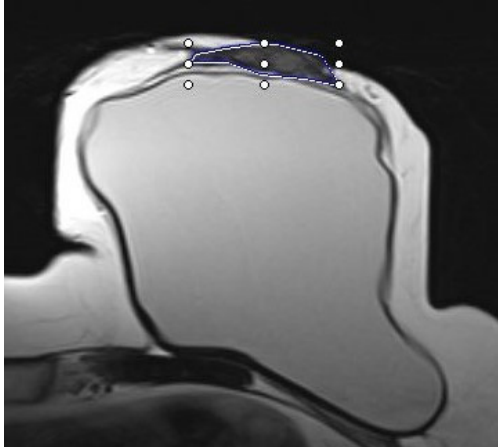
Figure 5. Volumetry of residual glandular tissue after risk-reducing mastectomy with implant T2- weighted image. The measurements were made using the image processing software Syngo.via (Siemens Healthcare GmbH, Erlangen, Germany).